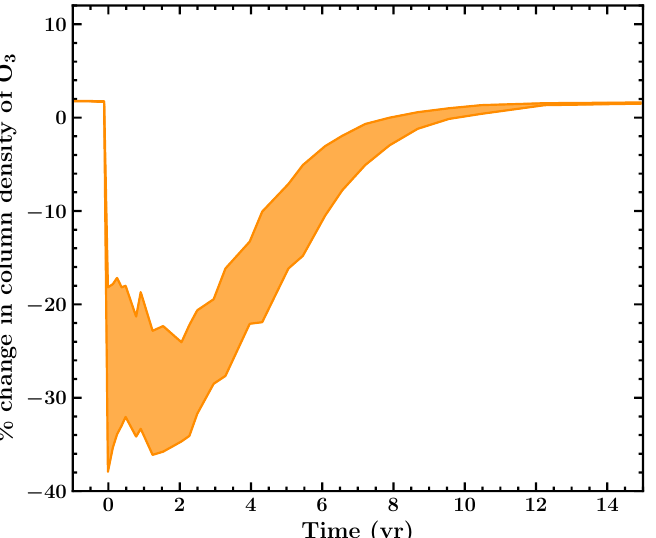
Figure 3. Global percentage reduction of the O 3 column density. The shaded region is the envelope of the curves computed by Thomas & Melott [74] by considering different latitudes | δ | ą 45 ˝ .